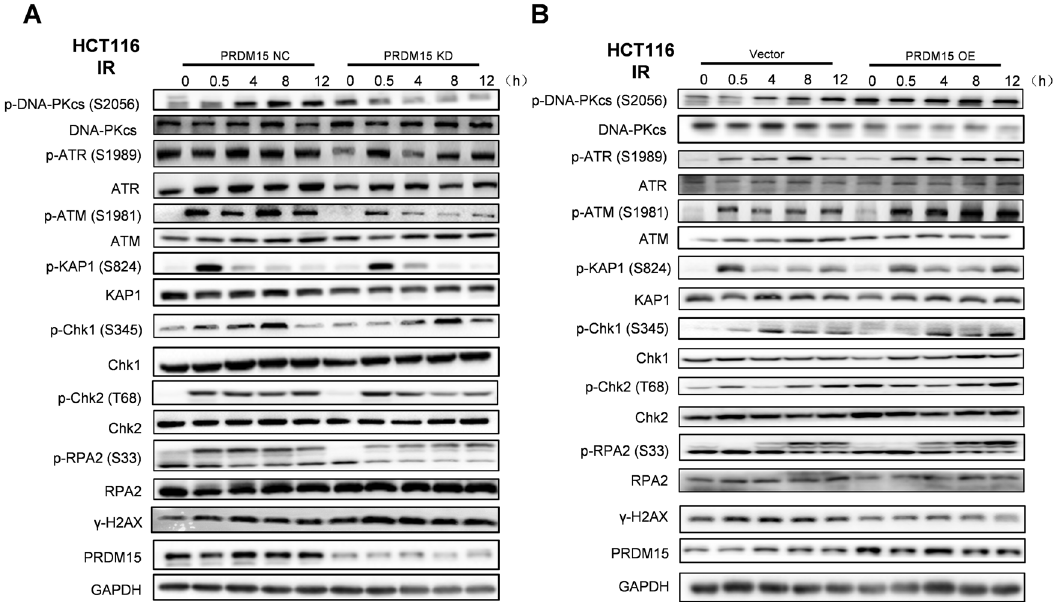
Fig. 4 PRDM15 is required for the activation of DNA-PKcs mediated DNA repair. A Representative images of Western Blot of the protein expression in DNA Damage Response pathway in PRDM15-NC and PRDM15-KD cells after 8 Gy IR at different time points. B Representative images of Western Blot of the protein expression in DNA Damage Response pathway in PRDM15-NC and PRDM15-OE cells after 8 Gy IR at different time